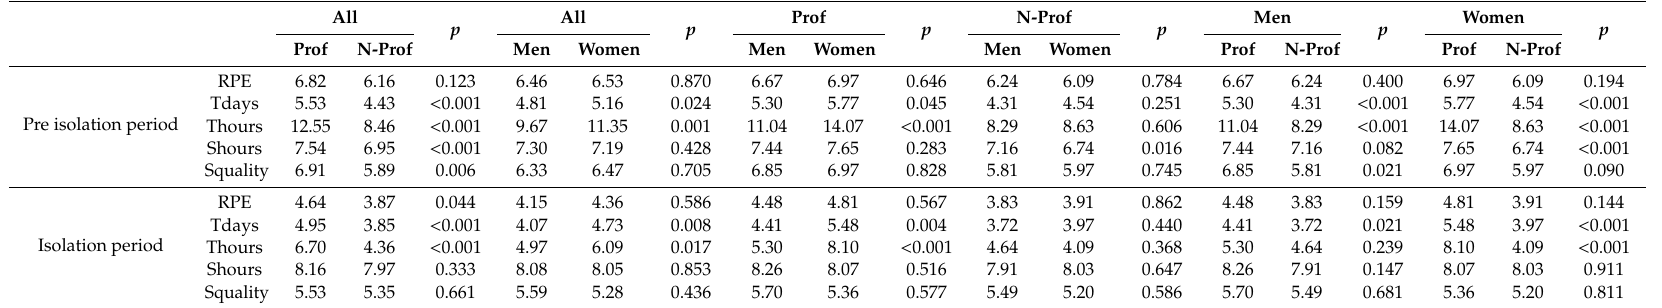
Table 3. Di ff erences by gender and professional sport level before and during isolation periods.